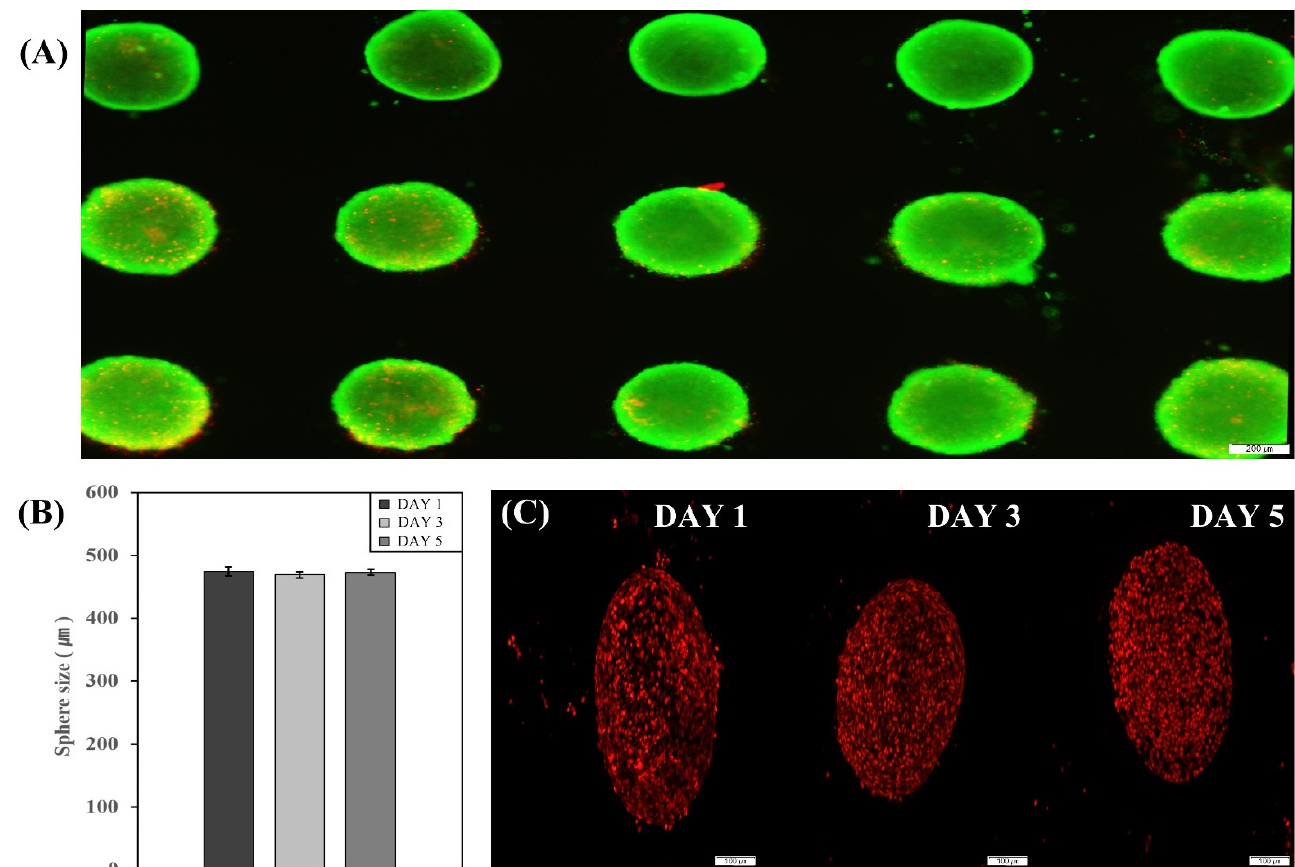
Figure 1. hADSCs spheroids were generated in the non-attachable microwell plate for five days. ( A ) Two-color fluorescence LIVE/DEAD assay. Live cells are shown as a bright green color, while a red-orange color represents dead cells. Scale bar, 200 μ m ( B ) The spheroid size of hADSCs at one, three and five days after seeding on microwell plate. ( C ) Annexin V staining assay for identification of cell apoptosis/necrosis at five days after seeding. Scale bar, 100 μ m .